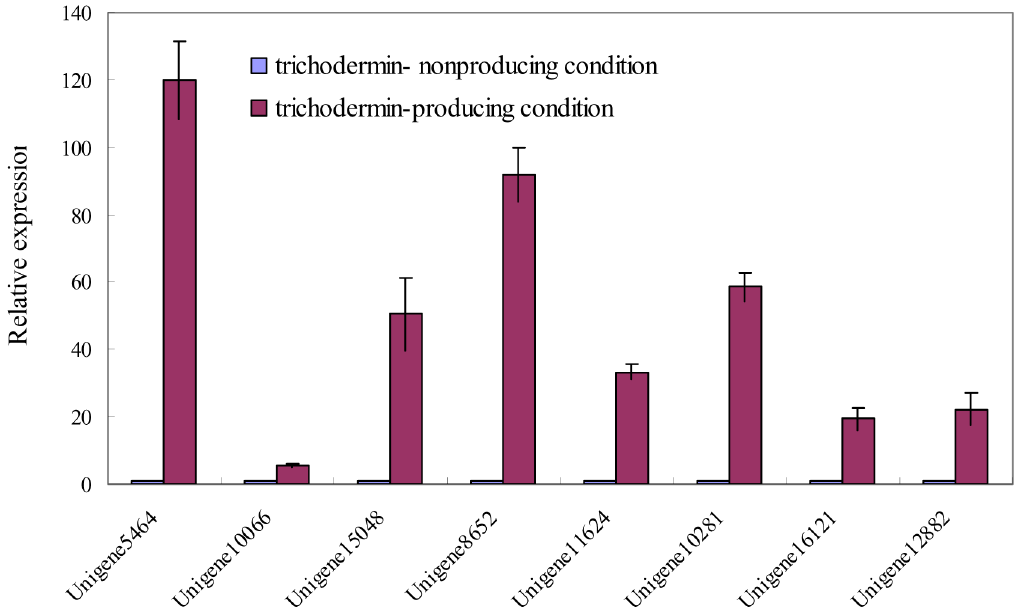
Figure 5. Quantitative PCR (qPCR) analysis of several unigenes in T.brevicompactum 0248 under the trichodermin-nonproducing or trichodermin-producing condition. Transcription levels of the unigenes were normalized to the b -tubulin gene. Data represent the mean and standard errors (n=3).